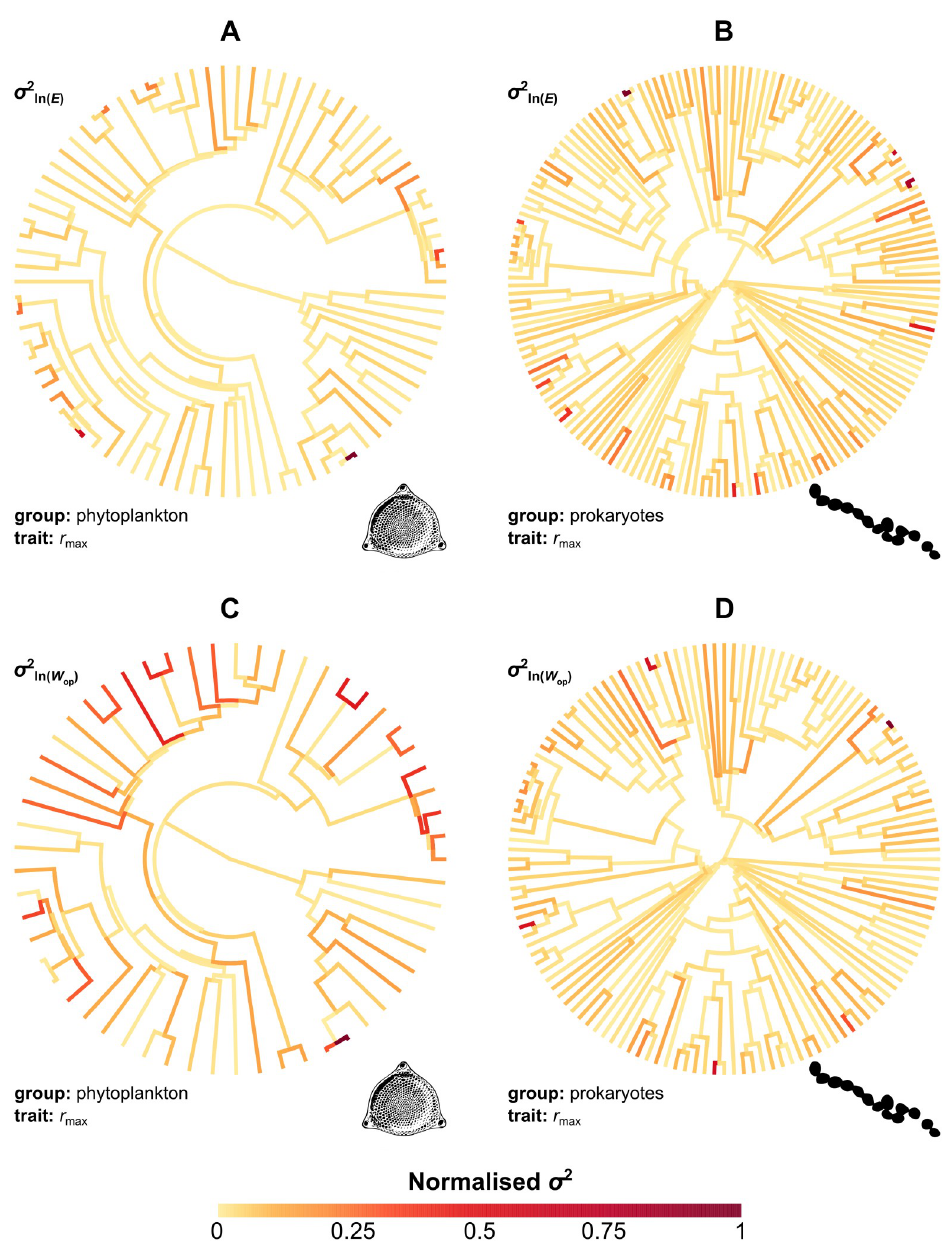
Fig 5. Variation in the evolutionary rate of thermal sensitivity across the phylogeny. Rates were estimated by fitting the stable model of trait evolution to each dataset and were then normalised between 0 and 1. Most branches exhibit relatively low rates of evolution (orange), whereas the highest rates (red and brown) are generally observed in late- branching lineages across different clades. The raw data underlying this figure are available at https://doi.org/10.6084/